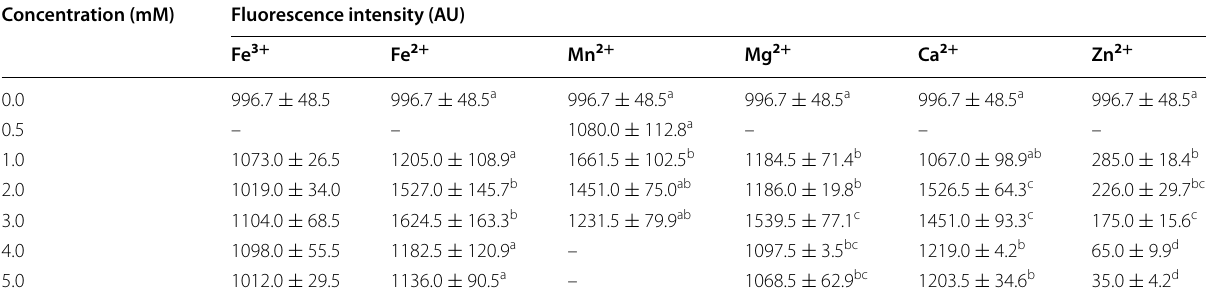
Mean values in the same column with different letters (a, b, c, d) are significantly different ( P < 0.05). The final results are expressed as the mean (n 3) of 100-fold diluted spore samples =